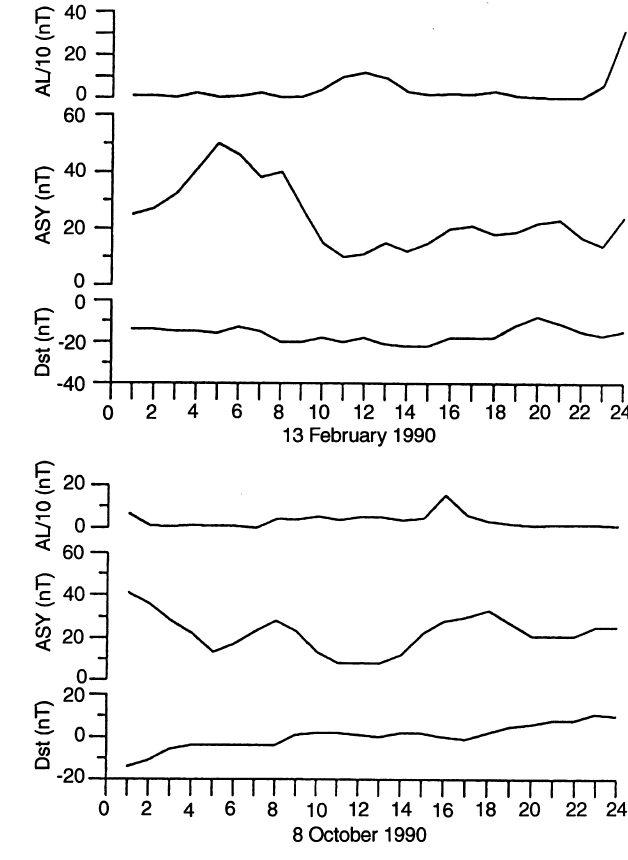
Fig. 7. Dst , ASY , and AL /10 for four international quiet days